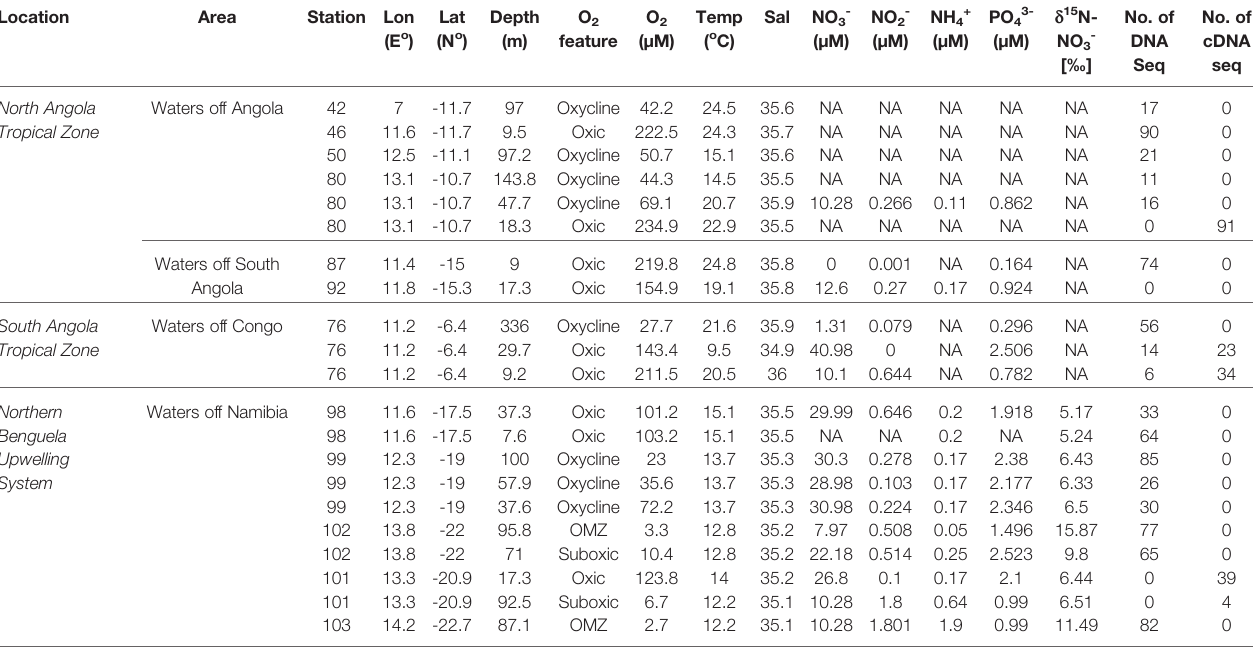
TABLE 1 | Overview and description of the nifH clone library. Location